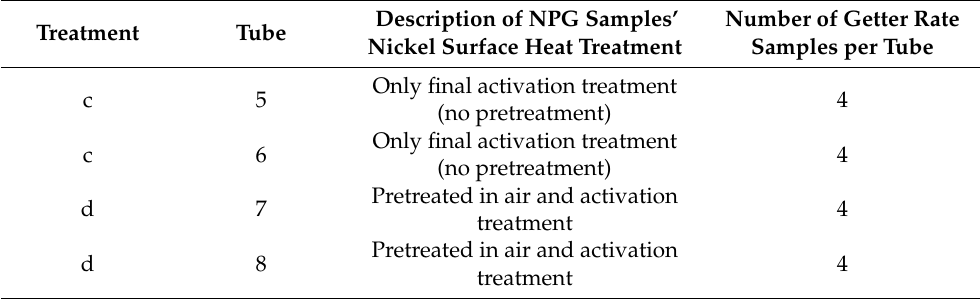
Table 1. Test Matrix for Getter Rate